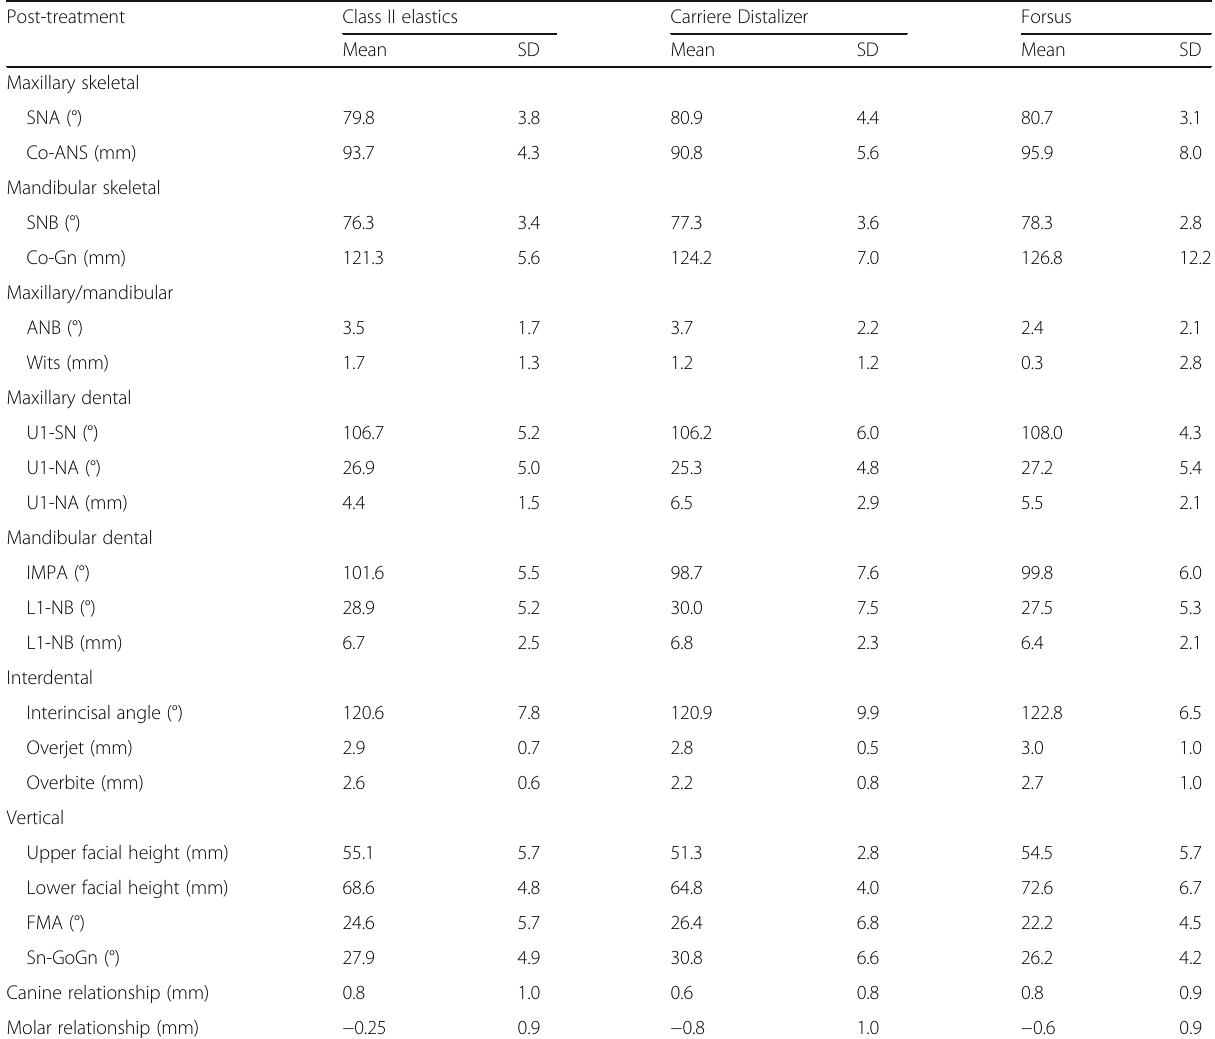
Table 3 Post-treatment cephalometric measurements and canine/molar relationship